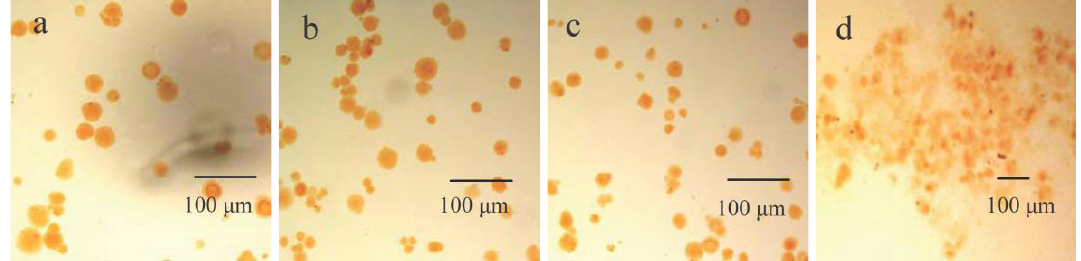
Figure 1. Optical micrographs of wet CaAlg beads ( a ), calcium alginate-chitosan microspheres (CACM) coated with 0.5% chitosan ( b ), CACM coated with 1.0% chitosan ( c ) and CACM coated with 2.0% chitosan ( d